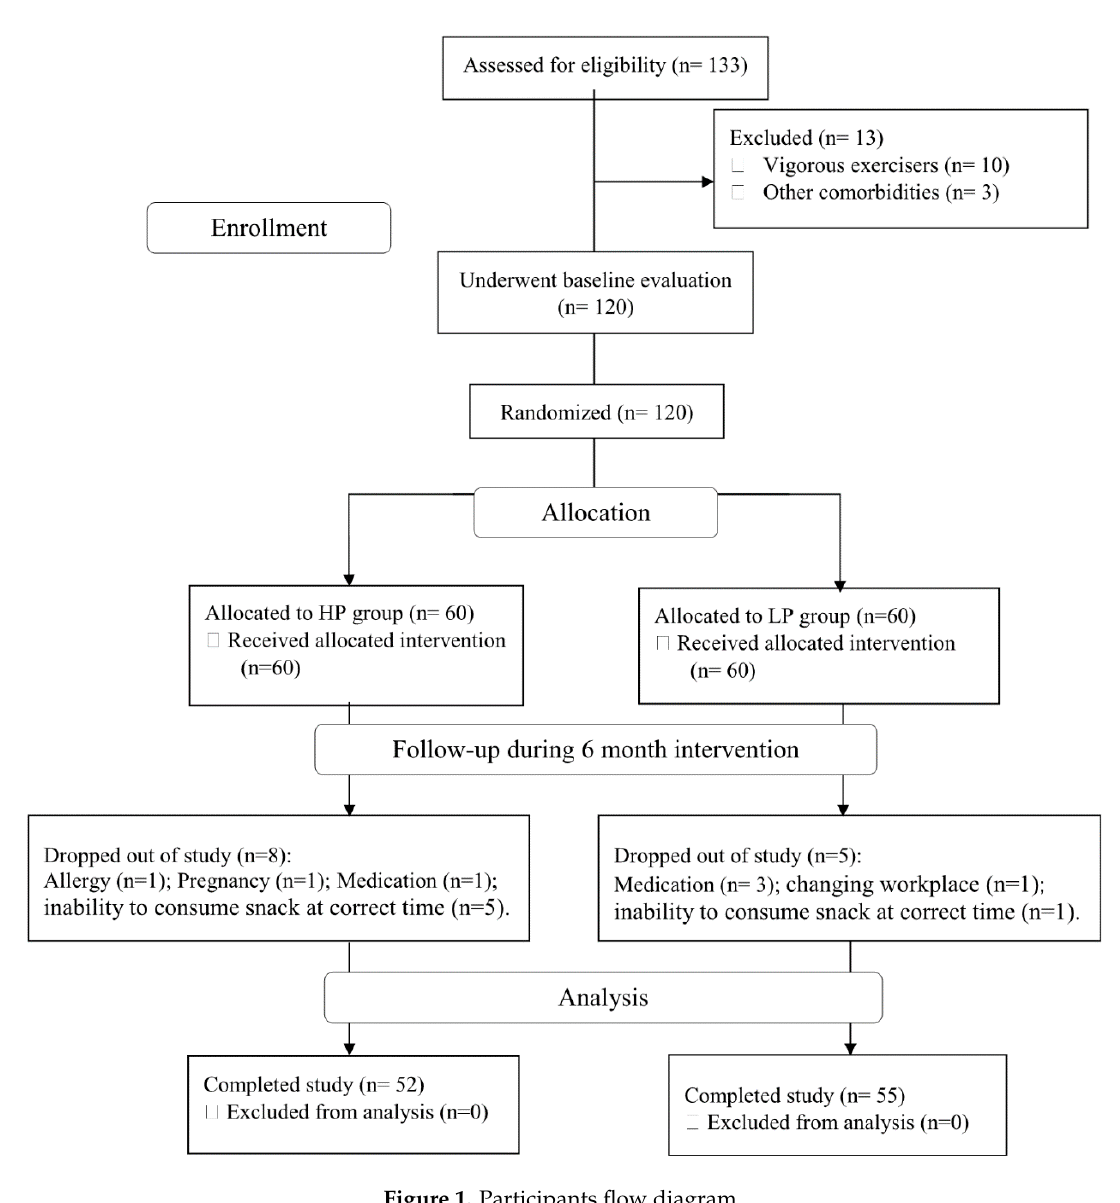
Figure 1. Participants flow diagram.